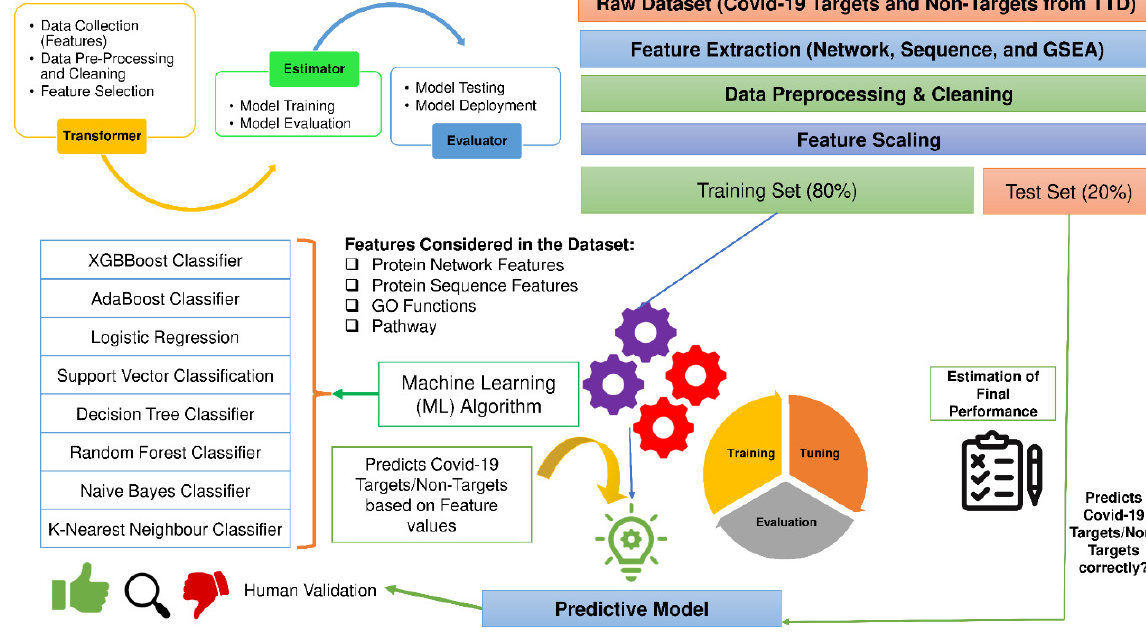
Figure 1. Computational workflow of ML-DTD.